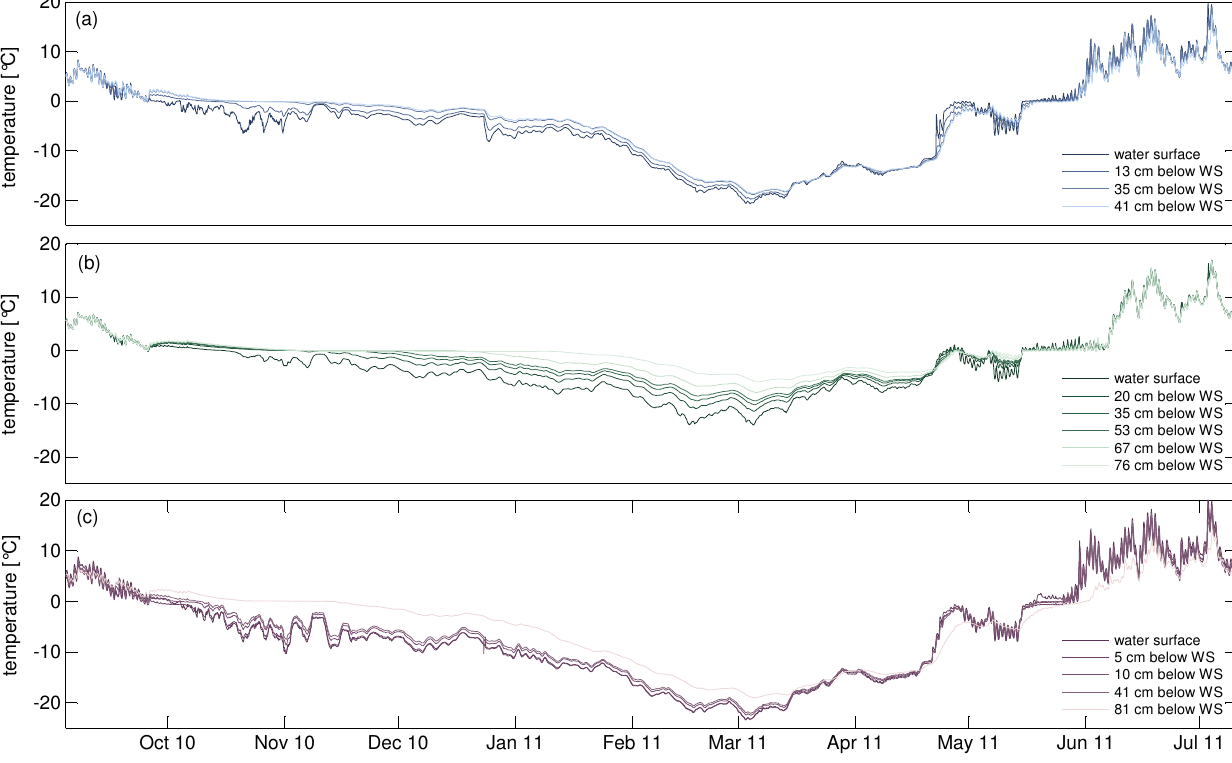
Northern Finland (Lloyd et al., 2001). Later snow melt (at the end of June) has been reported from Zackenberg, Greenland, and from Ny- ˚Alesund, Spitsbergen (Lloyd et al., 2001). With a mean annual permafrost temperature of − 8.6 ◦ C at 10.7 m depth, the study site is one of the coldest permafrost regions on earth (Romanovsky et al., 2010a). Brown and Ro- manovsky (2008) have presented records of permafrost tem- peratures from 27 circumpolar sites in the Northern Hemi- sphere. Comparable temperatures have been reported from West Dock in Northern Alaska (near Prudhoe Bay), and from Tiksi, which is 110 km southeast of Samoylov